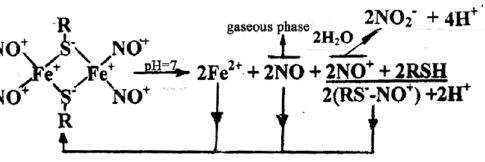
Figure 16. The successive conversion of B-DNIC-GSH into nitrite and GS-NO caused by treatment of their 0.5 mM solutions with 1.5 mM PCMB at pH 10.0 and the addition of 6 mM GSH (pH 1.0 − 2.0). Spectrum 1—The initial solution of B-DNIC-GSH (0.5 mM) pH 7.3. Spectrum 2—The same after the increase of pH to 10.0. Spectra 3 and 4—The same after successive treatment of B-DNIC-GSH with PCMB and GSH (pH 1.0 − 2.0). Spectrum 5—The same after subtraction of spectrum 3 from spectrum 4, suggesting the formation of GS-NO (0.5 mM) [40]. (With permission).